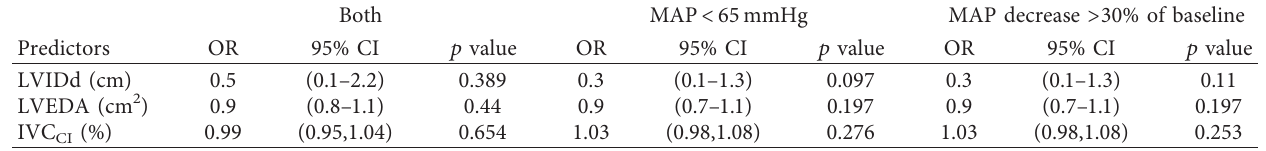
Table 4: Adjusted logistic regression models including one predictor at a time ( n �